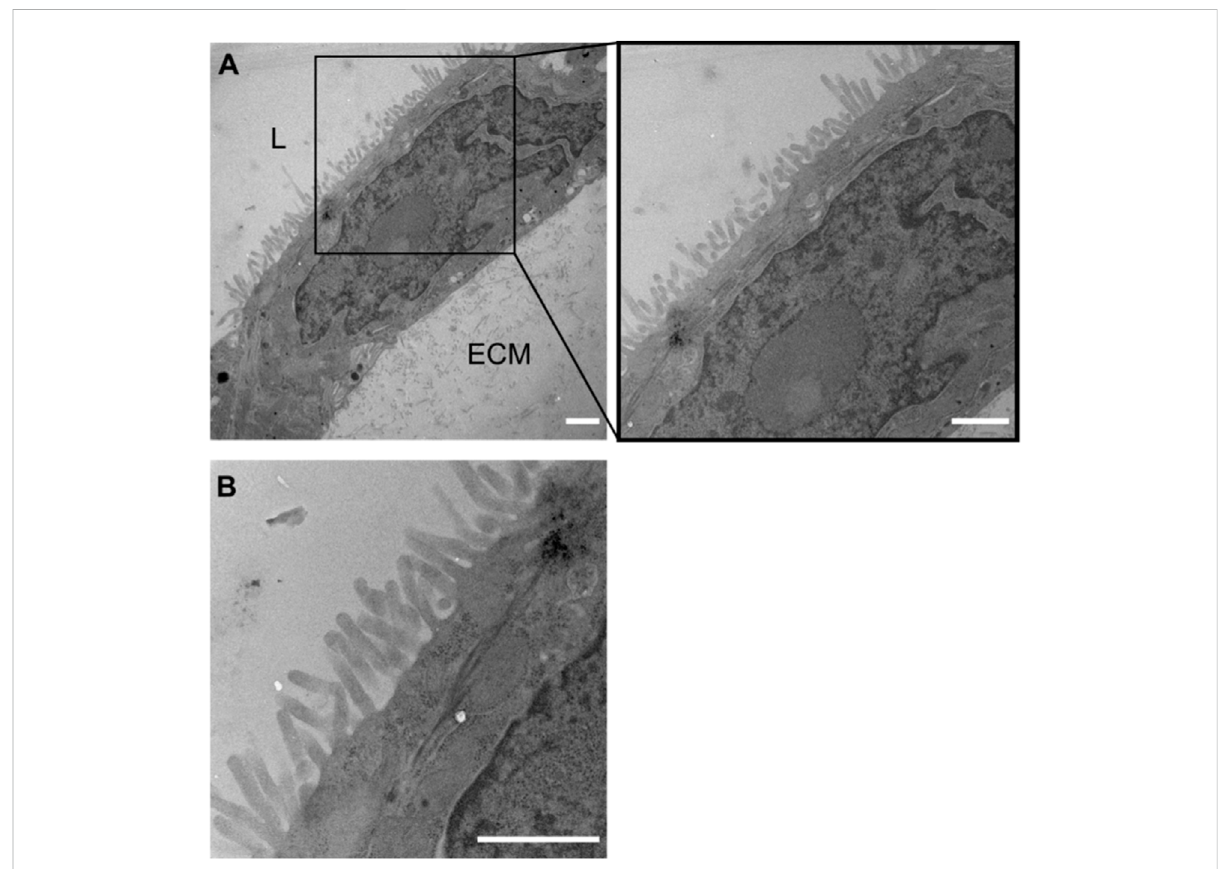
FIGURE 3 Formation of microvilli in coculture tubules identi fi ed by TEM. (A) Micrograph of a monolayer cell tubule with the lumen top left (marked by L) and the ECM located towards the bottom right (marked by ECM). Clear microvilli formation towards the luminal side of the coculture tubule, but a complete lackofmicrovillionthesidefacingtheECMdemonstratingthecorrectapicobasalmorphologicaldifferentiationafter4 daysofculture. (B) Zoom (A) represents the organization of dense microvilli. Scale bar is 1 µm in all